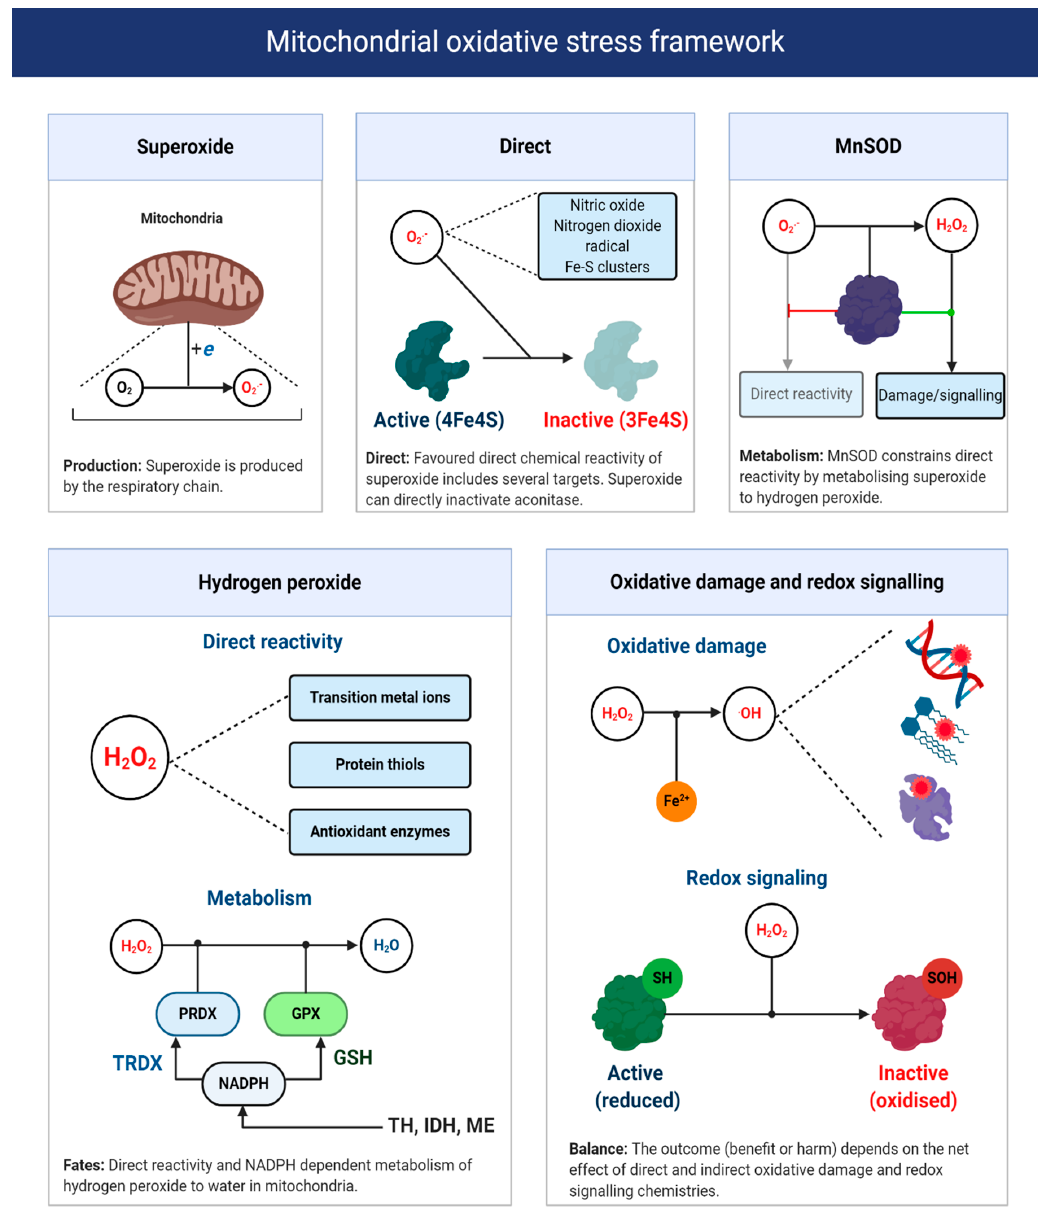
Figure 6. A mitochondrial oxidative stress framework. Upper panels depict the direct chemical reactivity of superoxide, which is regulated by MnSOD activity. The lower left panel depicts the direct chemical reactivity and metabolism of H 2 O 2 . The lower right panel illustrates two H 2 O 2 -focused chemical defined examples of oxidative damage and redox signaling. The net function of mitochondrial superoxide production will depend on whether direct and indirect reactivity (via H 2 O 2 and other species like hydroxyl radical) is beneficial or harmful. Abbreviations: TH = transhydrogenase; IDH = NADPH-dependent isocitrate dehydrogenase; and ME = NADPH-dependent malic enzyme. Redox signaling refers to the ability of ROS to signal changing protein activity, function, lifetime, binding partners, and location [241–243]. While redox signals can take many guises (e.g., direct reactivity of superoxide with aconitase [208,244]), a major form is defined by H 2 O 2 -mediated reversible oxidation of protein thiols (cysteine residues) and the resultant formation of distinct chemotypes from sulfenic acids (RSOH) to disulfide bonds (RSSR), depending on contextual factors (e.g., RSOH stability [58,241,245,246]). The mammalian proteome contains over 200,000 protein thiols, with many being located in the matrix (their matrix abundance is in the mM range), often in a deprotonated state (favoring direct H 2 O 2